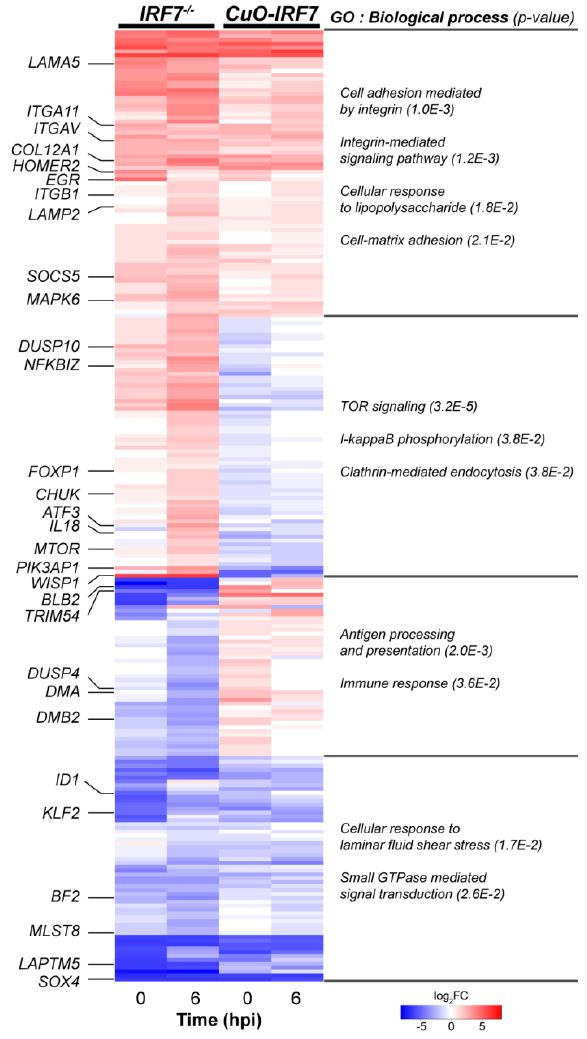
Figure 3. Comparative analysis of IRF7 knockout and overexpression. The expression profile of 245 common DEGs between IRF7 knockout ( IRF7 -/- / IRF7 wt ) and IRF7 overexpression ( CuO-IRF7 / Control ) [35] at 0 h (mock) and 6 hpi with H6N2 infection (heatmap). Each cluster’s representative genes are indicated on the left of the heatmap, and biological process gene ontology terms and their p-values are indicated on the right.